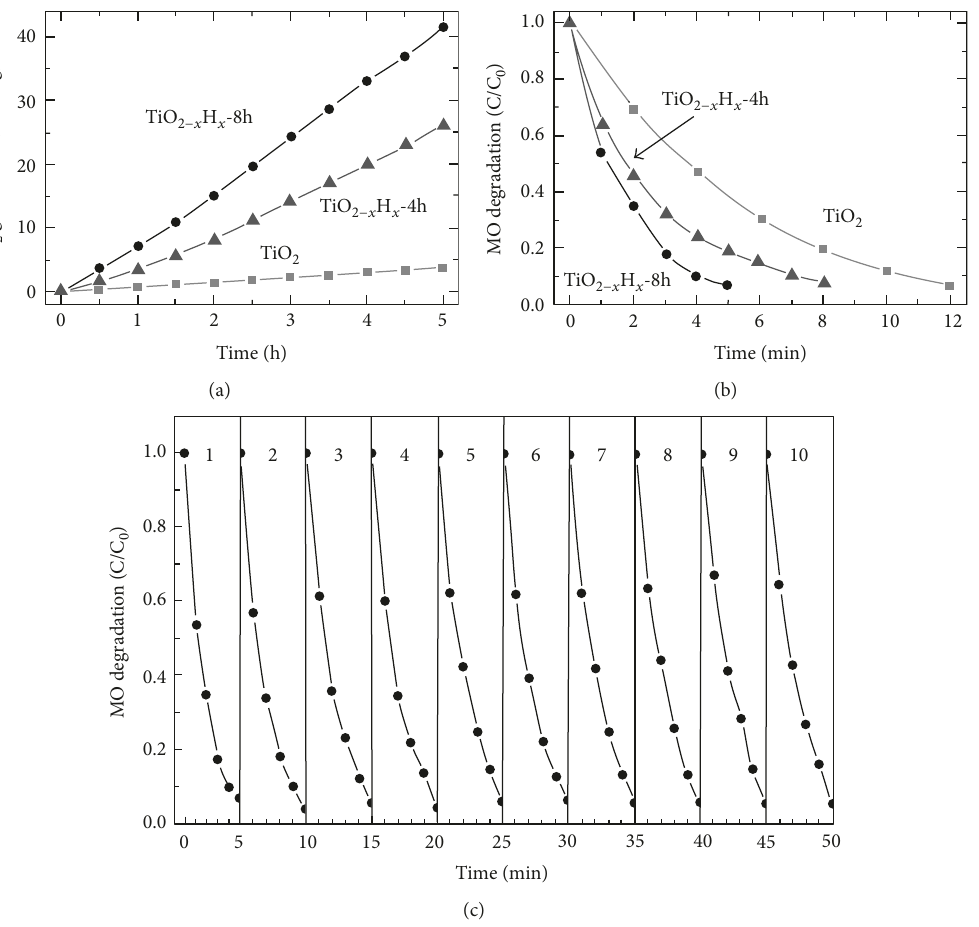
Figure 7: Solar light-driven photocatalytic (a) water splitting for H TiO H -4h, and TiO H -8h. (c) Cycling tests of solar-driven photocatalytic activity of TiO 2 − x x 2 − x x [33]. Copyright (2013)